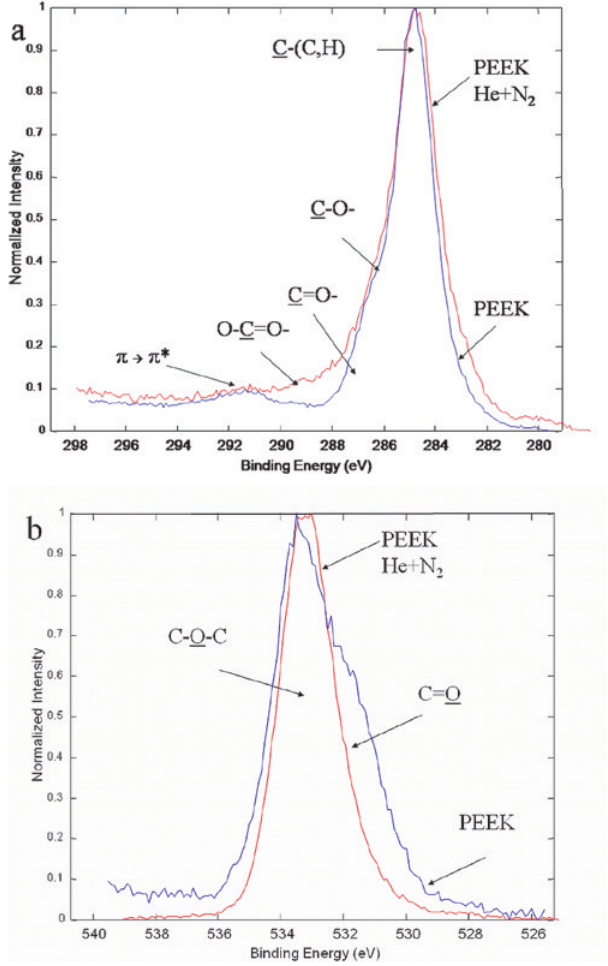
Fig. 4: XPS C1s (a) and O1s (b) spectra of PEEK without modification (PEEK) and modified in He+N 2 atmosphere (PEEK He+N 2